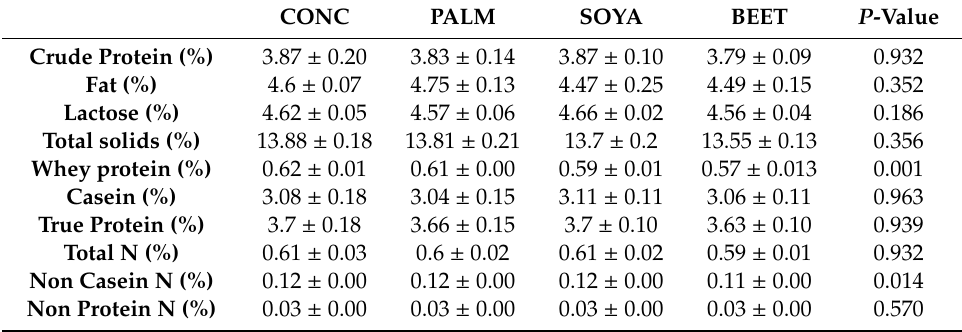
Table 6. The e ff ect of dietary treatment (parlour concentrate (CONC), palm kernel expeller (PALM), soya hulls (SOYA), and molassed beet pulp (BEET)) on bulk milk composition (% ± standard deviation).